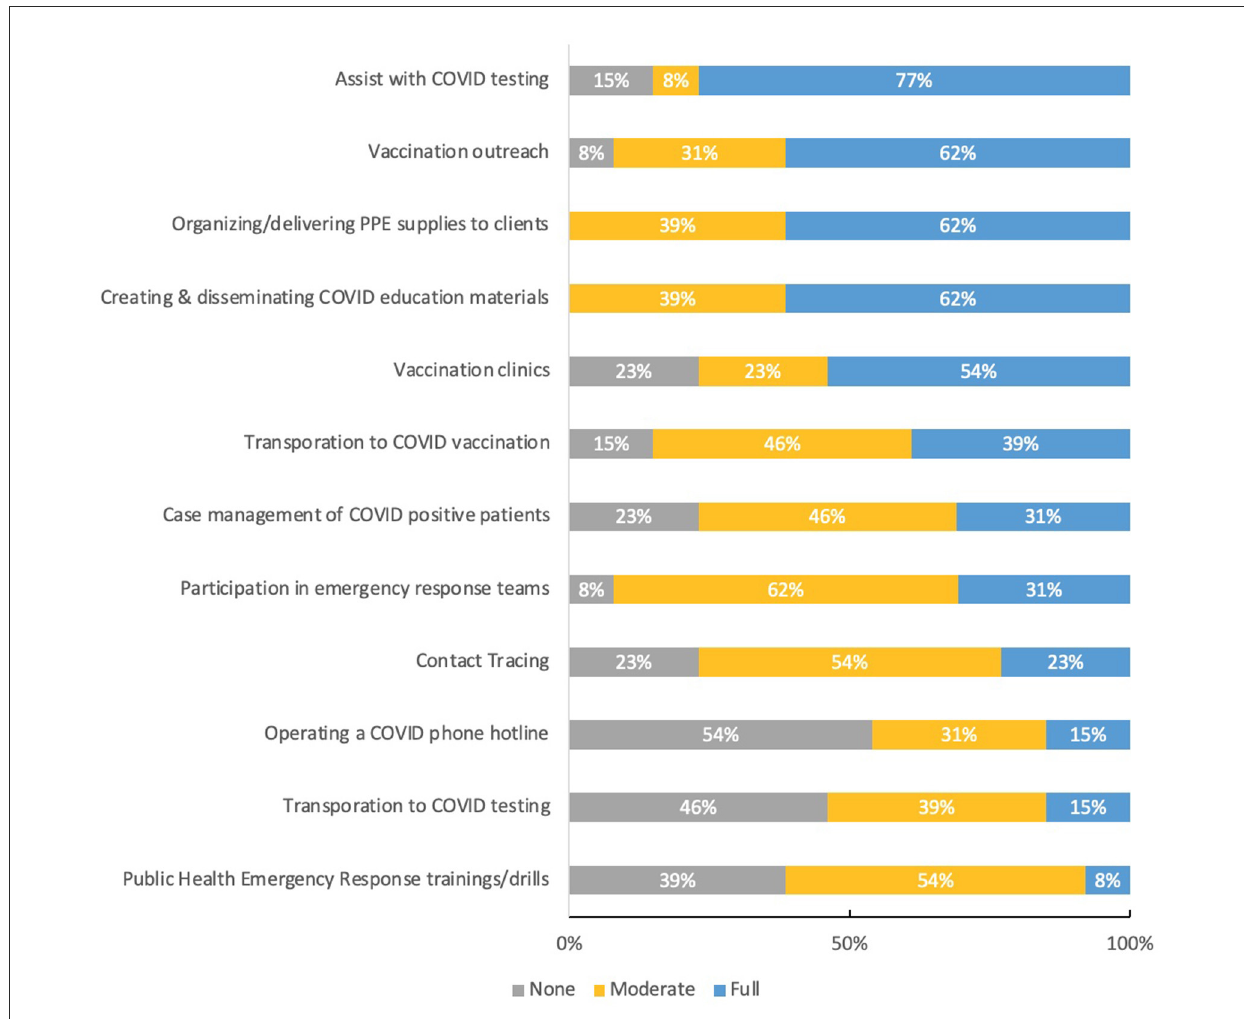
FIGURE3 CHR manager descriptions of CHR program involvement in COVID-19 response